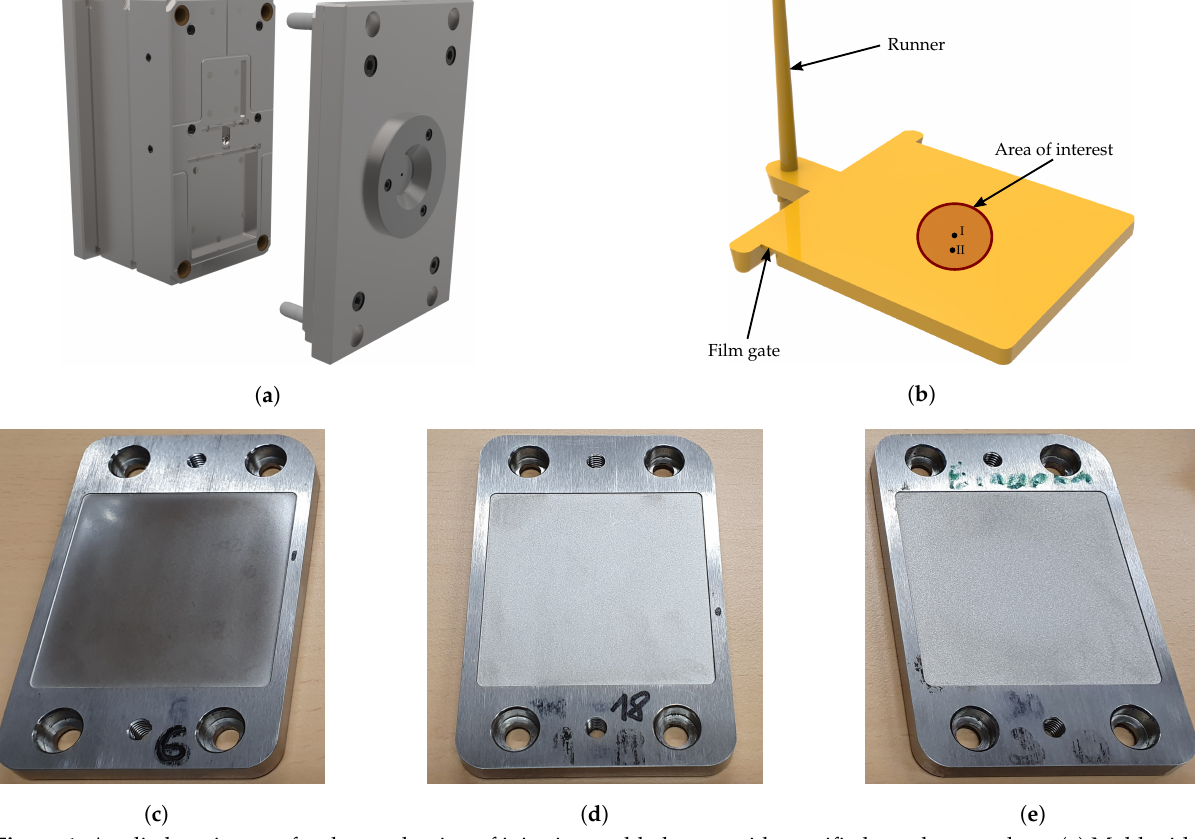
Figure 1. Applied equipment for the production of injection molded parts with specified roughness values. ( a ) Mold with interchangeable inserts. ( b ) Injection molded part with a dimension of 60 mm × 60 mm × 4 mm applying an insert without a specified roughness. ( c – e ) Provided mold inserts from Richard Hiebler GmbH., Stainz, Austria, with target line roughness values R a of 0.2 µ m, 0.8 µ m, and 3.2 µ m to produce rectangular shaped parts with a dimension of 60 mm × 60 mm × 2.5